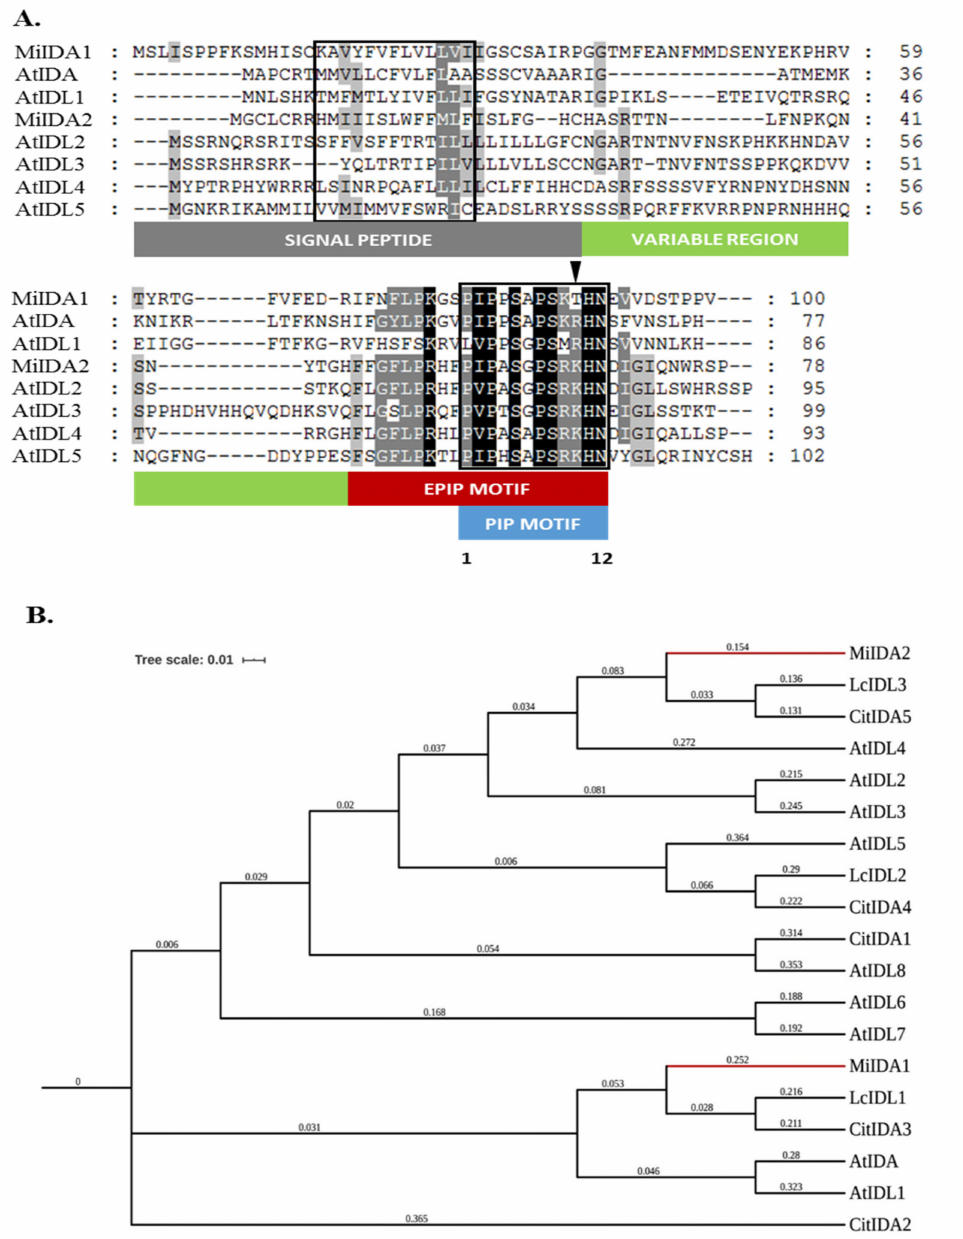
Figure 1. Protein sequence alignment of MiIDAs with Arabidopsis IDA/IDL proteins ( A ), and phylogenetic relationships between MiIDA and other IDA proteins ( B ). ( A ) Alignment was performed using the ClustalW2 program (https://www. genome.jp/tools-bin/clustalw (accessed on 15 August 2018)) with manual adjustment using GeneDoc (MSA editor and shading utility version 2.7.000). The amino acid sequences of MiIDA1 (QGF19396.1), MiIDA2 (QGF19397.1), AtIDA (NM_105550.1), AtIDL1 (NM_113464.2), AtIDL2 (NM_001085327.2), AtIDL3 (NM_001085091.1), AtIDL4 (NM_001084711.1) and AtIDL5 (AY642386.1) were aligned. The signal peptide, the variable region of the extended PIP domain (EPIP) and conserved PIP domain are marked with rectangles. The arrowhead indicates residues at position 10 of the PIP domain. ( B ) Phylogenetic relationships among the mango, lychee, citrus and Arabidopsis IDA proteins. MiIDA1, MiIDA2 LcIDL1 (Lychee_GLEAN_10054315), LcIDL2 (Lychee_GLEAN_10027620), LcIDL3 (Lychee_GLEAN_10009234), AtIDA, AtIDL1, AtIDL2, AtIDL3, AtIDL4, AtIDL5, AtIDL6 (NM_120612.1), AtIDL7 (AK118348.1), AtIDL8 (AK221754.1), CitIDA1 (Ciclev10017342m), CitIDA2 (Ciclev10033211m), CitIDA3 (Ciclev10033191m), CitIDA4 (Ciclev10003011m), and CitIDA5 (Ciclev10026873m) sequences were used. Bootstrap consensus trees were inferred from 100 replicates and graphically designed with iTOL (Interactive tree of life. V5) https://itol.embl.de/ (accessed on 15 August 2018). Branch lengths are